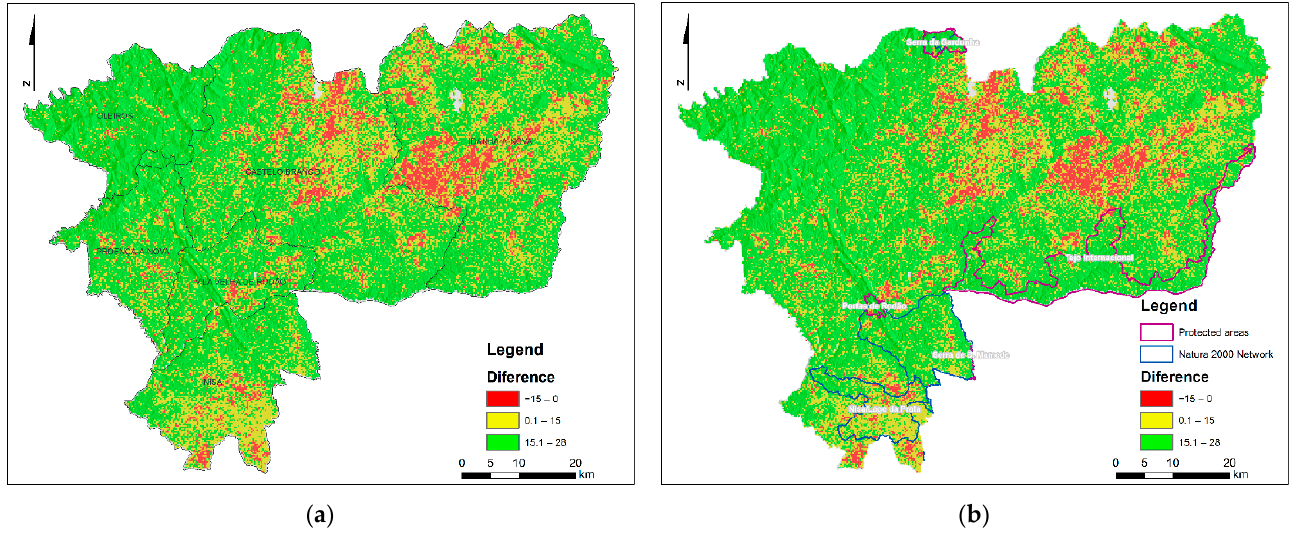
Figure 5. Algebraic subtraction between the DRASTIC and DRASTICAI ( a ) municipalities within the study area, ( b ) protected areas, and Natura 2000 Network areas overlap.